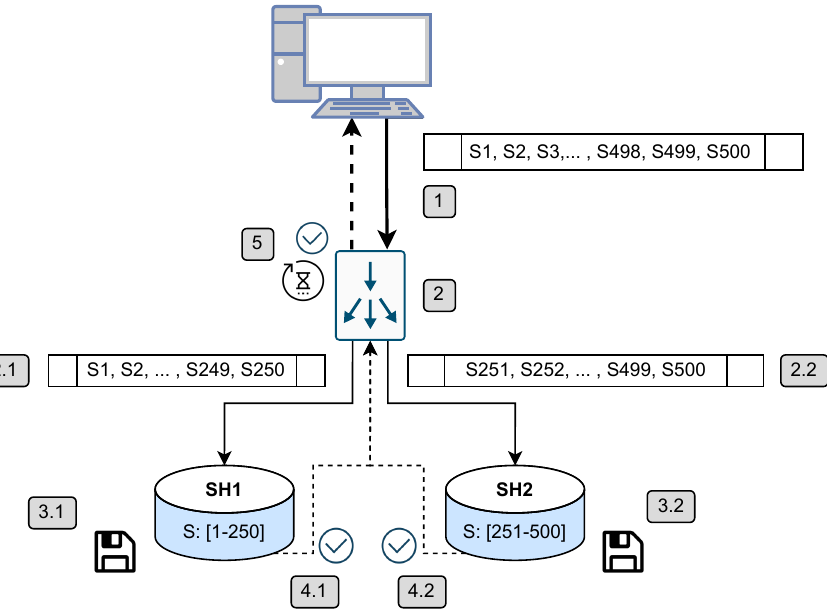
Figure 15. Briefed data ingestion procedure under a setup following 1:1*500 approximation with two ingestion shards, each holding half of the